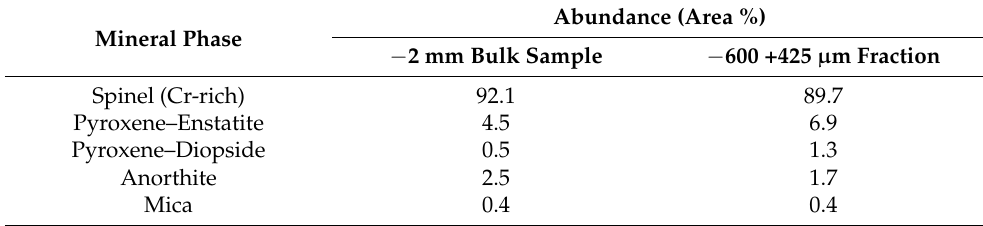
Table 4. Modal mineralogy data (in area %) from the EPMA map data.